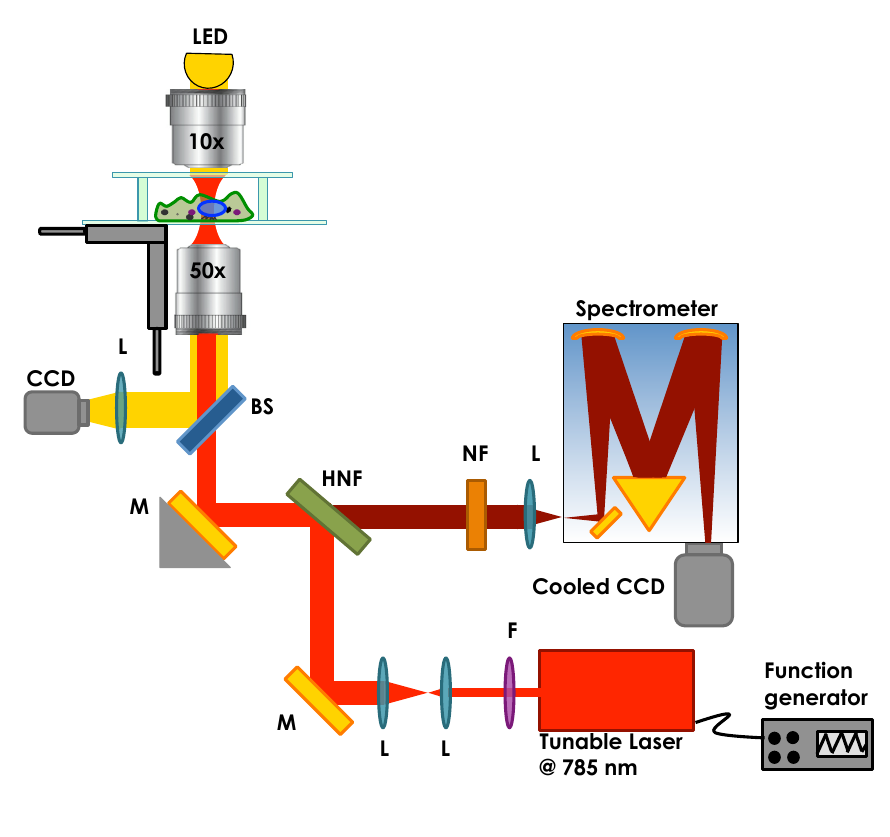
Figure 2. Schematic of our modulated Raman microscope system. A tunable laser at 785 nm is used to excite Raman scattering. The laser beam is introduced into an inverted microscope through a high numerical aperture objective. The scattering light from the sample is collected by the same objective, filtered by the holographic notch filter and coupled into a spectrometer equipped with a cooled CCD camera. Abbreviations: M, mirror; L, lens; F, filter; BS, beam splitter; NF, notch filter; HNF, holographic notch